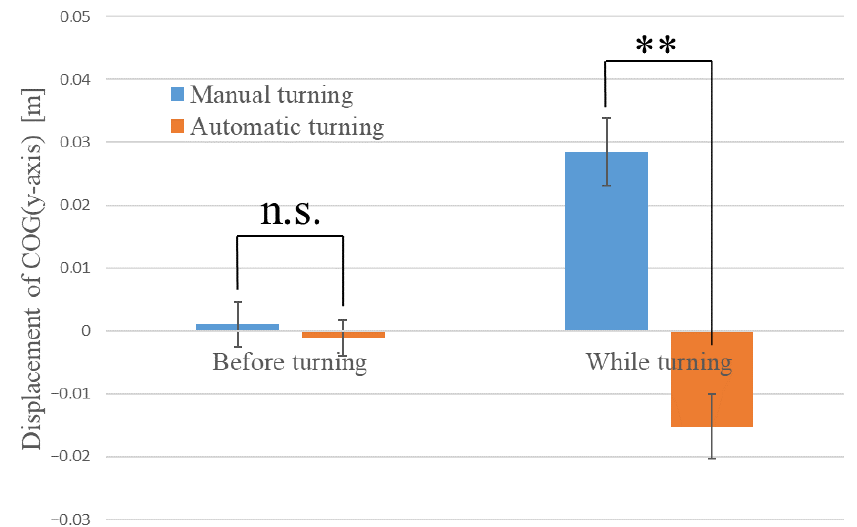
Figure 8. Average values of COG ( y -axis) before and after turning.